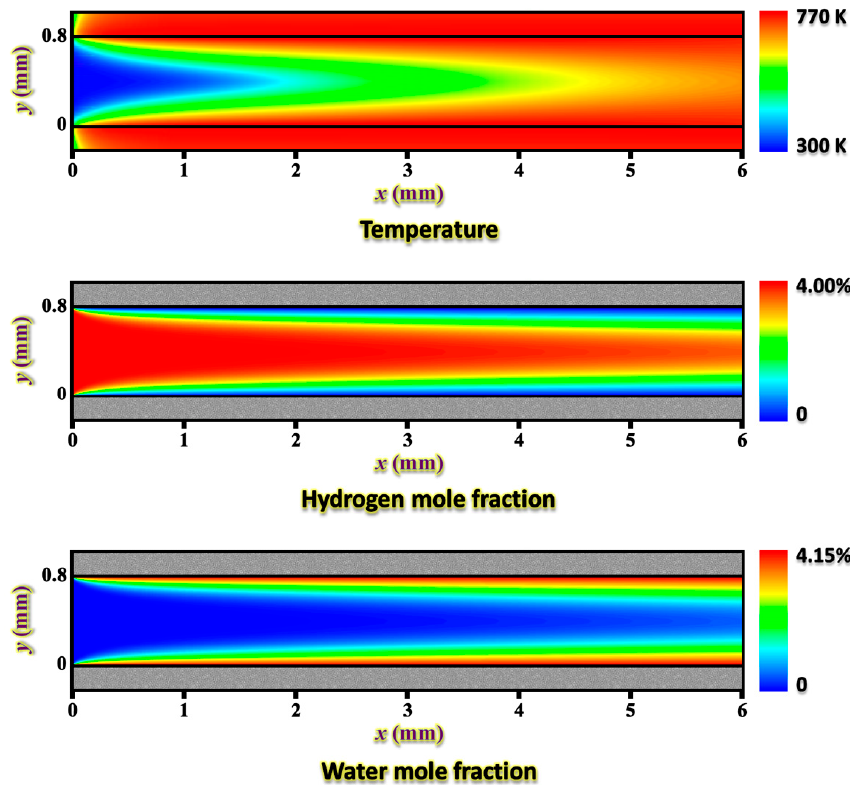
Figure 6. Contour plot of the temperature and hydrogen and water mole fractions for Case A shown in Table 2.